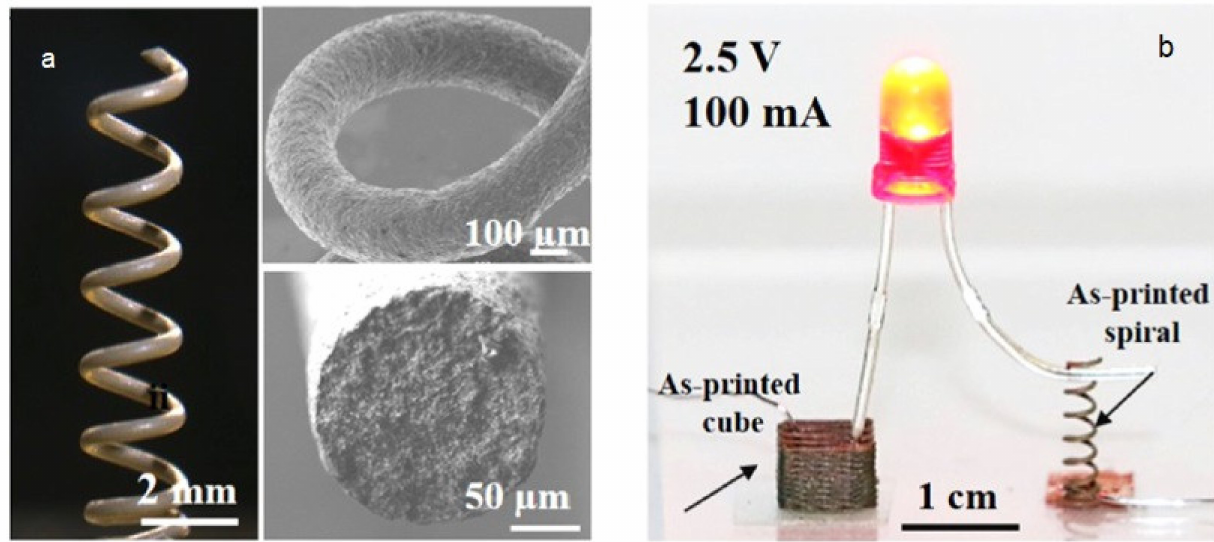
Figure 13. ( a ) Freeform 3D spiral. ( b ) Demonstration of the conductivity of as-printed structures, showing a cubic scaffold and a spiral connected to a circuit lighting up a red light-emitting diode (LED) under a voltage of 2.5 V with a current of 100 mA. Copyright 2019 ACS. Reprinted with permission from ref.